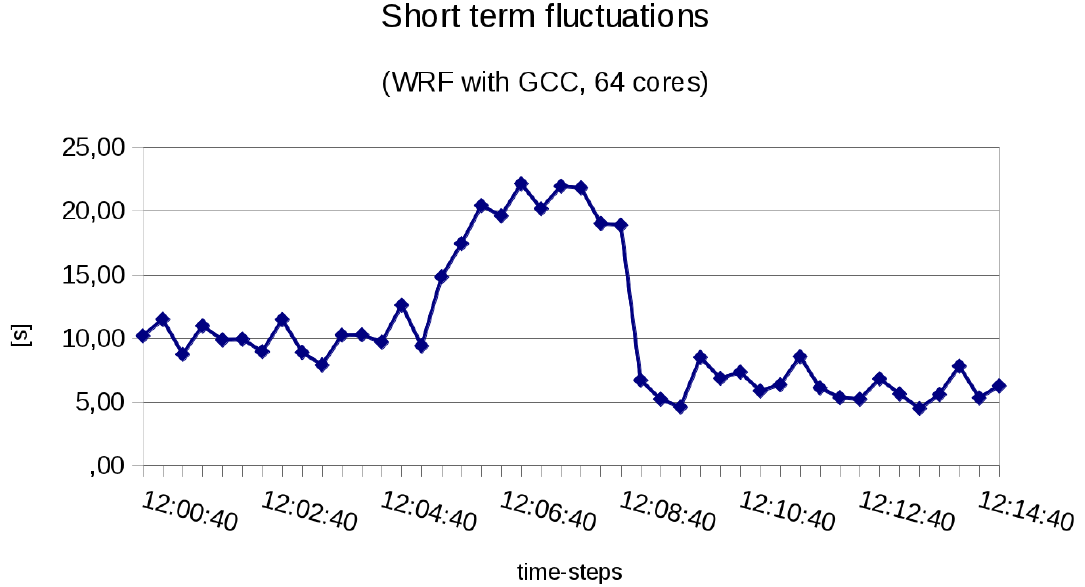
Fig. 3. Short term fluctuations of a WRF run at 64 cores with GCC. One clearly can see the short term fluctuations due to overall high network load on Tornado where the time needed for the computation of one time step is 22.162s maximum compared to 4.508s minimum what equals a span of 492% where no span should exist at